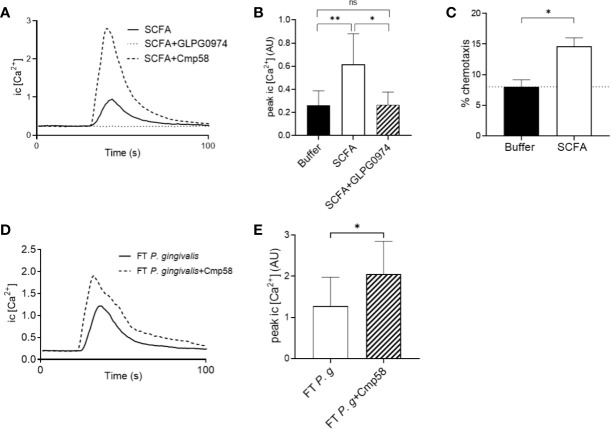
Neutrophil cytosolic Ca2+ signaling and chemotaxis in response to SCFAs found in P. gingivalis supernatants (A) A mixture of SCFAs, prepared based on the concentrations of SCFAs found in the supernatants of P. gingivalis, was used to stimulate neutrophils in the presence or absence of an FFAR2 antagonist (GLPG0974) or the allosteric modulator (Cmp58). Intracellular Ca2+ responses were monitored by flow cytometry. Graph shows the neutrophil intracellular Ca2+ response after stimulation with the SCFAs ± GLPG0974 or Cmp58 from one representative experiment. (B) Peak values of neutrophil intracellular Ca2+ signals after SCFA stimulation in the presence or absence of GLPG0974 (mean + SD, n = 9). Kruskal-Wallis test followed by Dunn´s multiple comparison test was used to calculate significant differences. (C) Neutrophils isolated from peripheral blood of healthy donors were allowed to migrate over a ChemoTx membrane towards chemotactic stimuli (i.e., SCFA or buffer) for 90 min (n=7). Migrated cells were quantified by measurement of myeloperoxidase activity after cell lysis. Values shown are calculated as percentage of positive control (100% migration) and are presented as mean values with SEM. Wilcoxon matched-pairs signed rank test was used to analyze statistics. (D) Human buffy-coat neutrophils were stimulated with the FT fraction of P. gingivalis 381 supernatant (± Cmp58), and intracellular Ca2+ responses were followed by flow cytometry. Graph shows the neutrophil intracellular Ca2+ concentration after stimulation with the P. gingivalis 381 FT fraction in the presence or absence of the allosteric modulator (Cmp58) from one representative experiment. (E) Peak values of neutrophil intracellular Ca2+ signals after P. gingivalis FT fraction stimulation with or without addition of Cmp58 (mean + SD, n = 8). Wilcoxon matched-pairs signed rank test was used to analyze statistics. ns >0.05, *<0.05, **< 0.01.